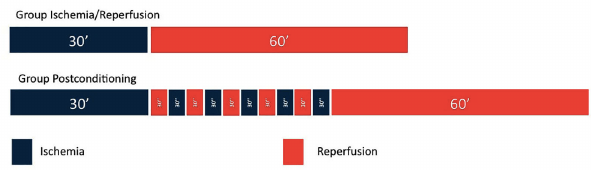
reperfusion in both